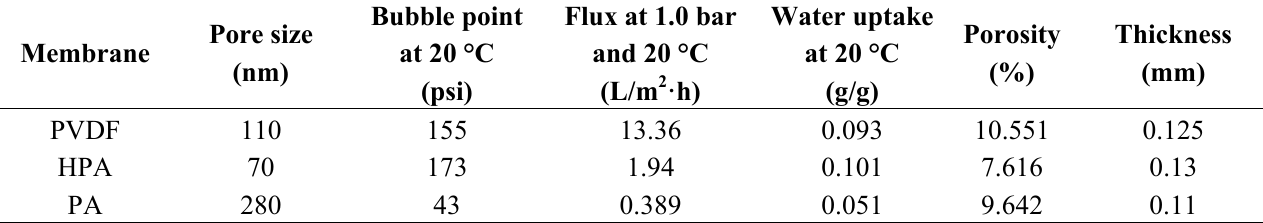
Table 1. Comparison of the physical properties of commercial PVDF, HPA membrane, and PA